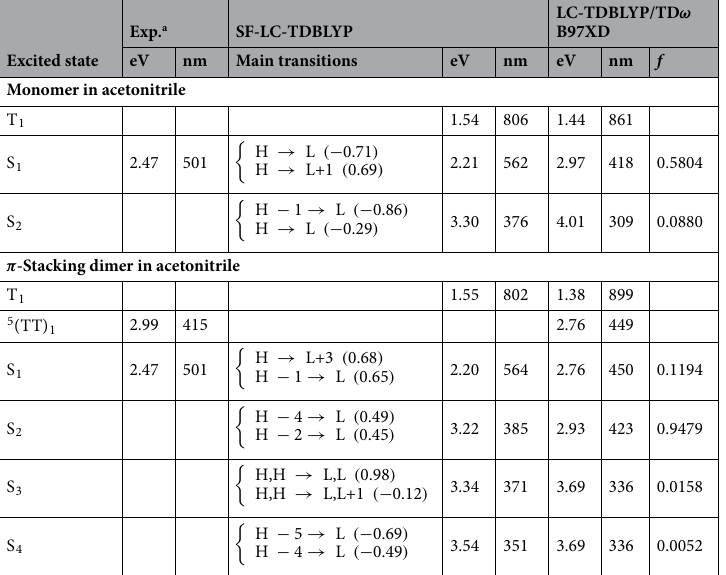
Table 1. Calculated vertical excitation energies (eV) of TMBODIPY derivative (a) for the monomer and π -stacking dimer by spin-flip LC-TDBLYP, LC-TDBLYP (monomer) and TD ω B97XD (dimer) with cc-pVTZ basis sets and CPCM solvent effect of acetonitrile. a Ref. 12 . Main transitions of spin-flip LC-TDBLYP excitations are also shown with the coefficients of the response functions in parentheses, in which the notations H and L indicate HOMO and LUMO. The oscillator strengths ( f ) of LC-TDBLYP (monomer) and TD ω B97XD (dimer) are also